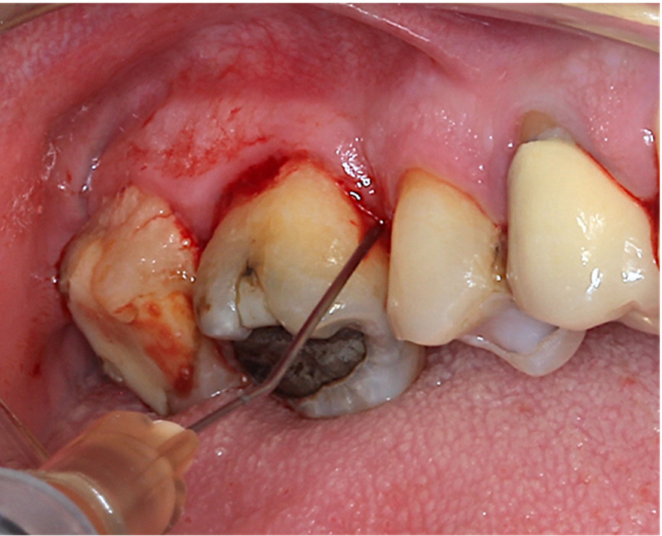
Figure 3. Application of the piperacillin-tazobactam 100/12.5 mg solution (Gelcide). Gelcide ® contains a powder (500 mg of piperacillin and tazobactam) and a liquid (5 mL of hydroalcoholic solution). Both components were mixed just before application and were administered at 2–3 drops per tooth with a different disposable blunt-tip syringe for each patient. Oral hygiene instructions were provided to the patients during the